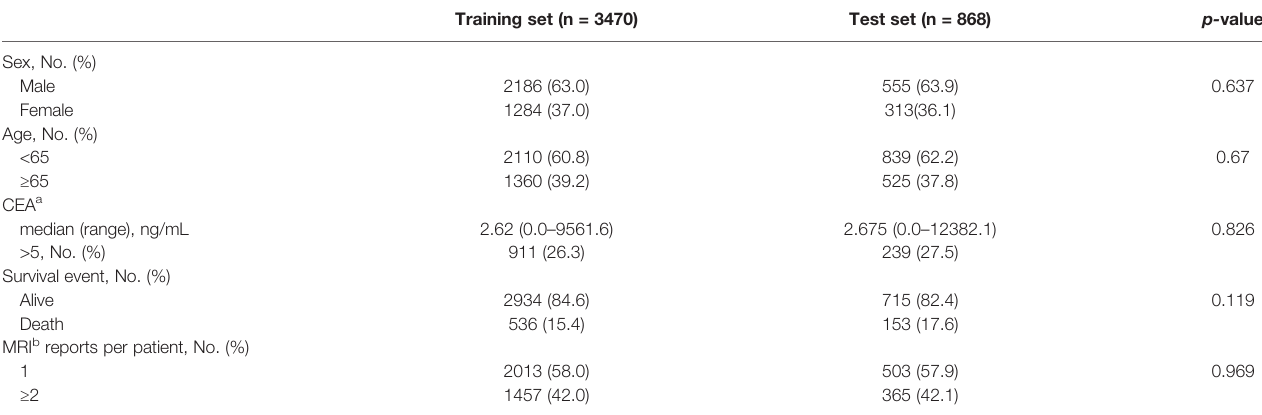
TABLE 1 | Patient demographic and clinicopathologic